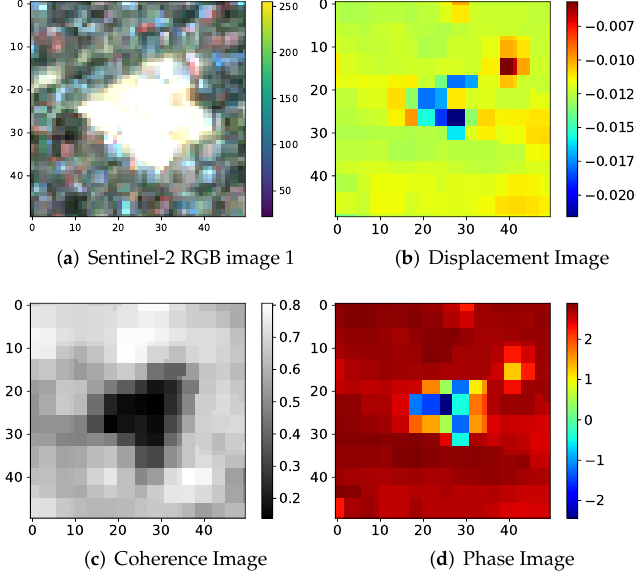
Figure 8. True-positive blob of a construction site in Germiston.